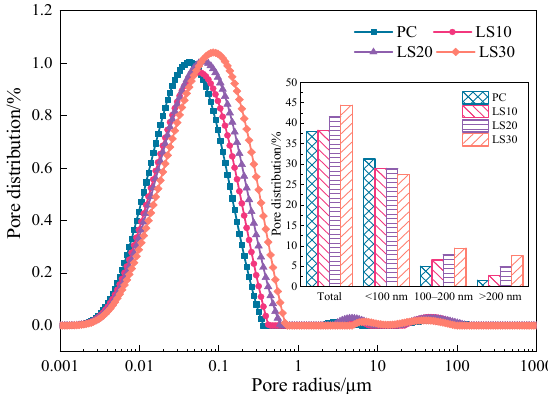
Figure 4. Pore size distribution in specimens cured for 56 days.